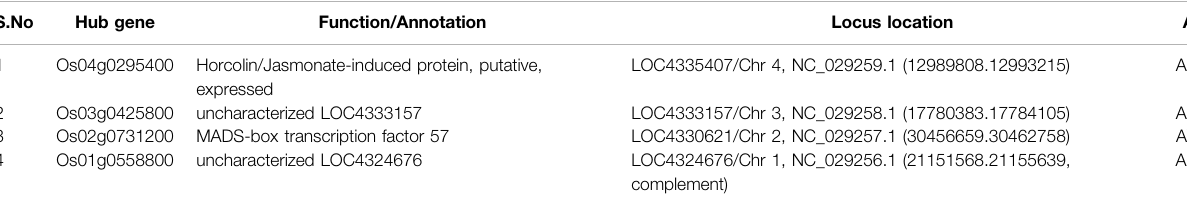
TABLE 1 | Identi fi ed hub genes with respect to their level of connectivity in the turquoise module.